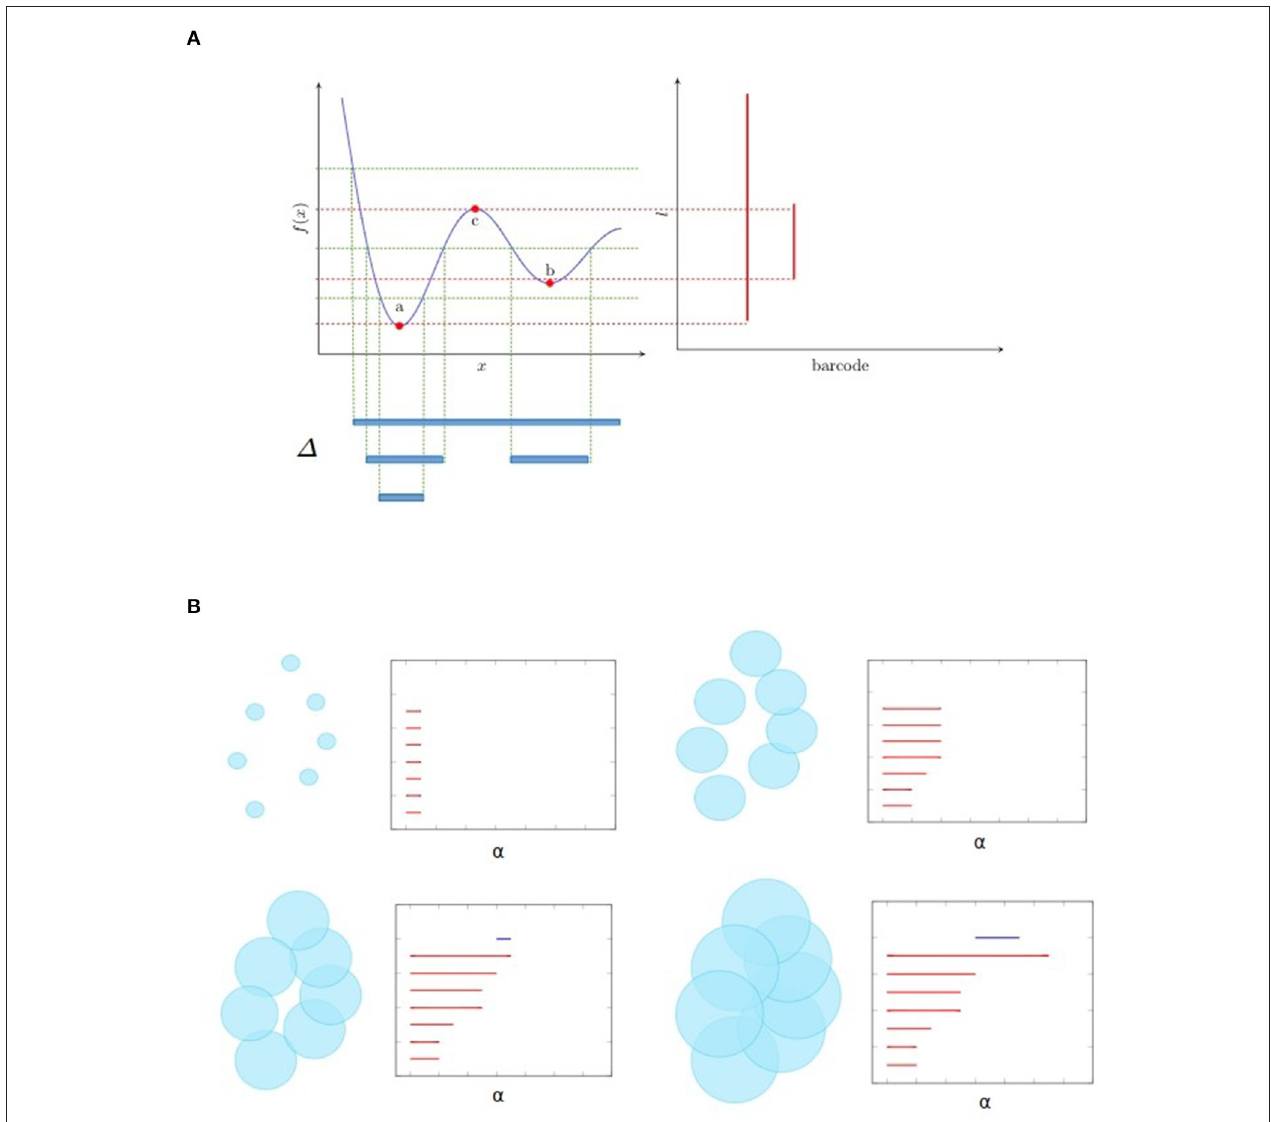
FIGURE 1 | Examples of filtration and the associated barcode. (A) shows the sublevel filtration of function f ( x ). The first and second connected component appear at point a and b respectively and merge together at point c , giving rise to two bars: one from a till infinity and the other from b to c . (B) shows several stages of Rips filtration. At first, all points are isolated and we have the same number of bars and points. As balls grow larger, some balls start to merge together, giving death to certain bars. Then one loop appears, marked as a 1-dimensional feature corresponding to the blue line in the barcode. Finally the loop is filled so the blue bar stops and every point merges into one component living